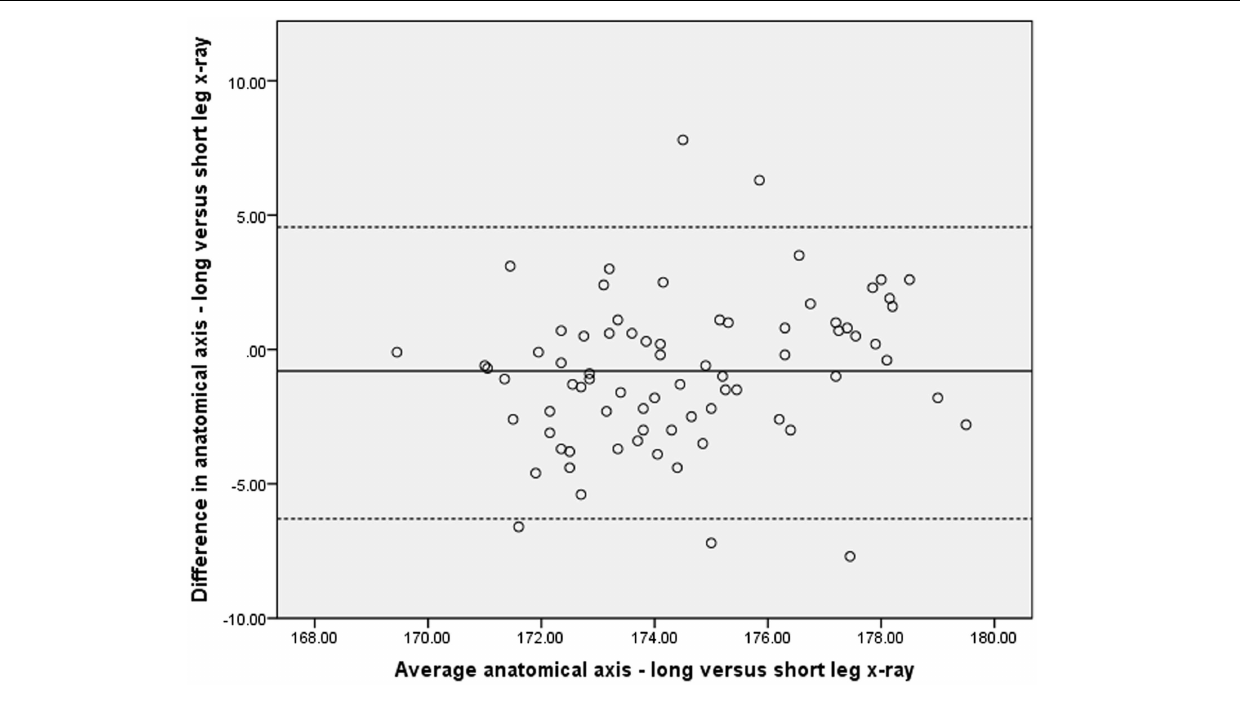
FIGURE 2 | Comparison of long and short-leg X-rays using Bland–Altman method .